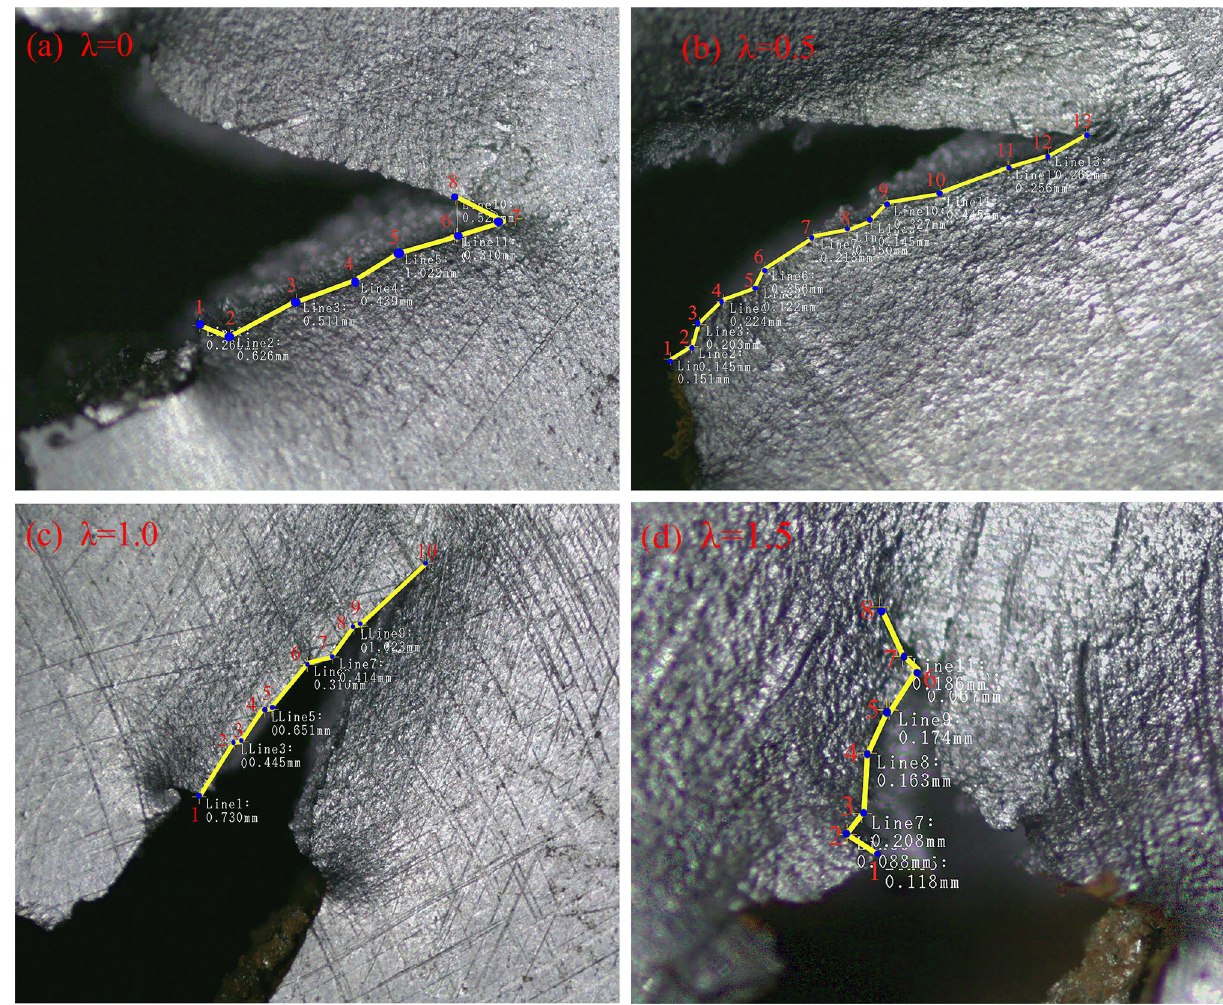
Fig. 14 Images of crack propagation paths for a λ = 0, b λ = 0.5, c λ = 1, and d λ = 1.5. (×100 magnification)